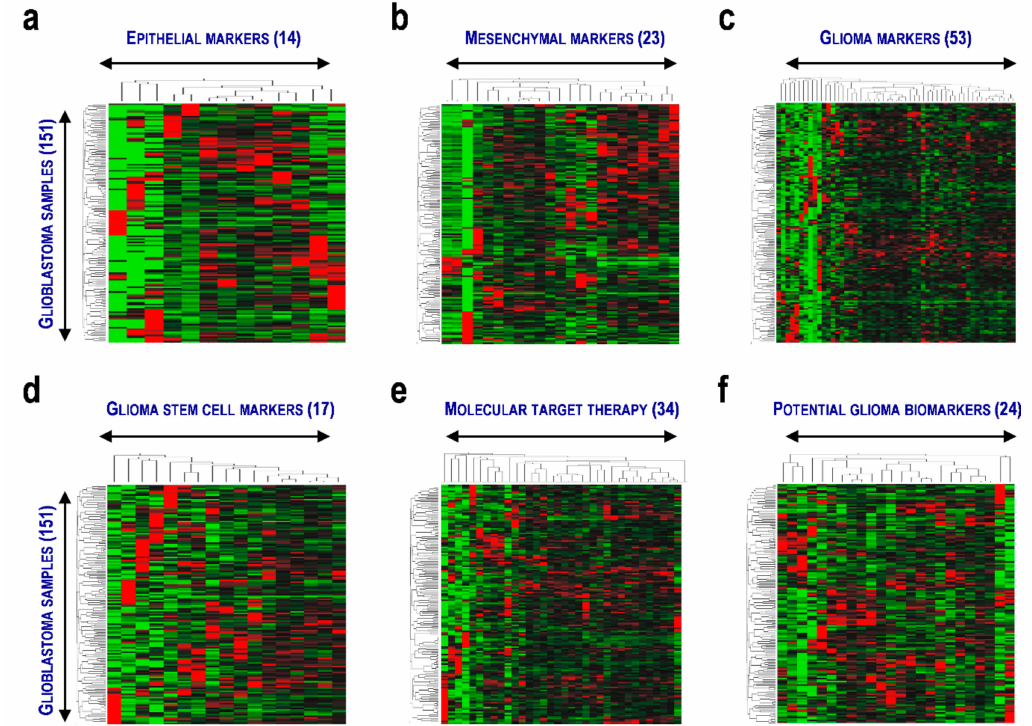
Figure 1. Di ff erential expression of the genes related to epithelial–mesenchymal transition and glioma in 151 patients with glioblastoma. Expression patterns with two-way clustering analysis are presented. ( a ) Epithelial marker gene set. ( b ) Mesenchymal marker gene set. ( c ) Glioma marker gene set. ( d ) Glioma stem cell marker gene set. ( e ) Molecular target therapy gene set. ( f ) Potential glioma marker gene set. Numbers in the parentheses denote the numbers of genes and glioblastoma